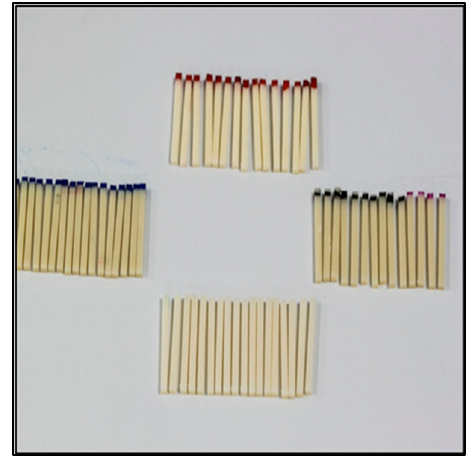
Figure 4. Tested specimens in all four